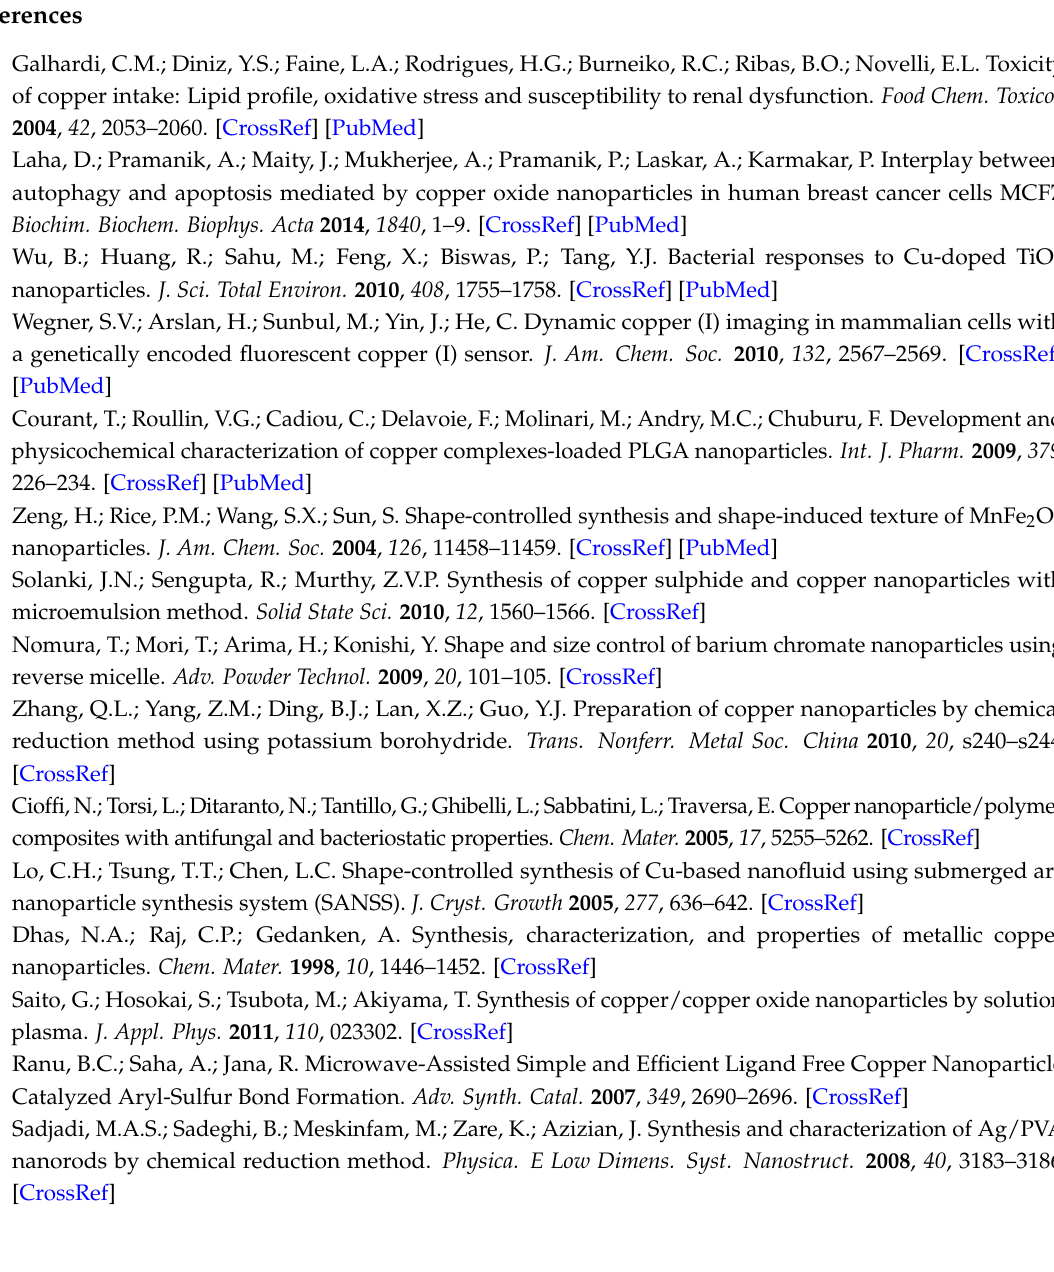
Figure S1: (1a) Rod-shaped nanoparticle and inset showing 5-fold center of the decahedral geometry at (111); (1b) lattice fringes and spacing of rod-shaped nanoparticle; (1c) uniform SAED patterns; (2a) Cube-shaped nanoparticle; (2b) lattice fringes and spacing of cube-shaped nanoparticle (2c) uniform SAED patterns; (3a) Pyramid-shaped nanoparticle; (3b) lattice fringes and spacing of pyramid-shaped nanoparticle; (3c) uniform SAED patterns; (4a) Spherically-shaped nanoparticles; (4b) lattice fringes and spacing of spherical nanoparticles; (4c) uniform SAED patterns, Figure S2: (a) Powder X-ray diffraction patterns of synthesized copper nanocrystals; (b) Energy Dispersive Spectra showing pure elemental